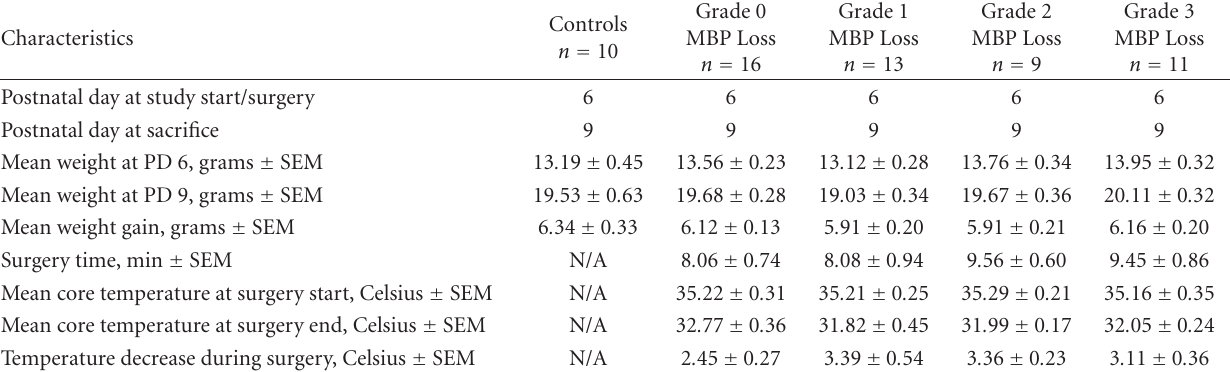
Table 2: Summary and comparison of study animal characteristics: by analysis